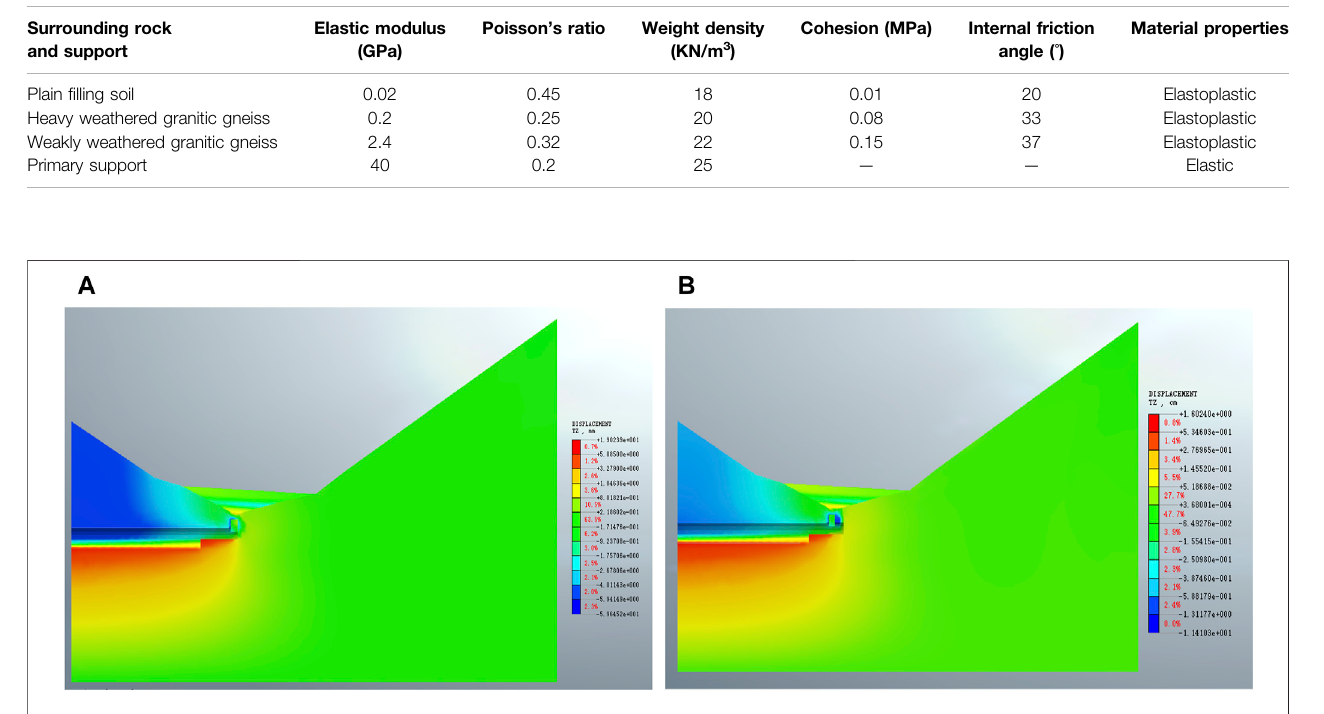
FIGURE 7 | Progressive process of collapse accident. (A) Displacement fi eld after excavating YK5+678 and (B) the displacement fi eld after excavating YK5+680.